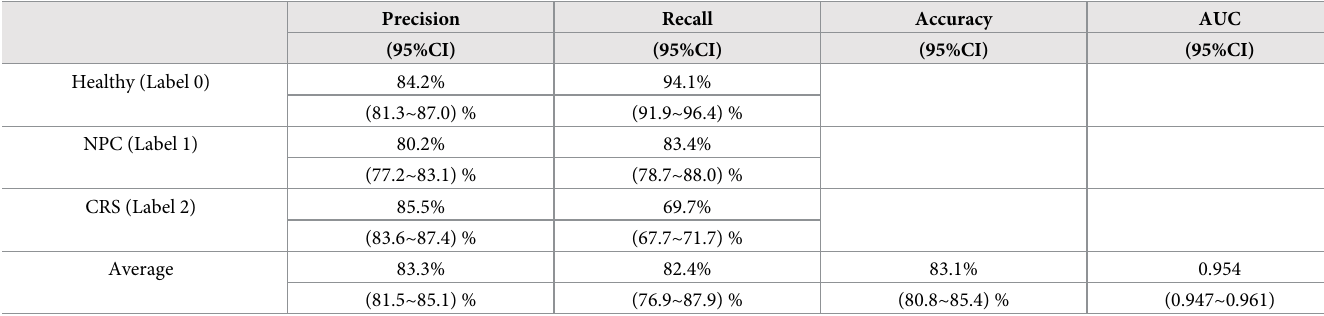
Table 3. The performance of RF.